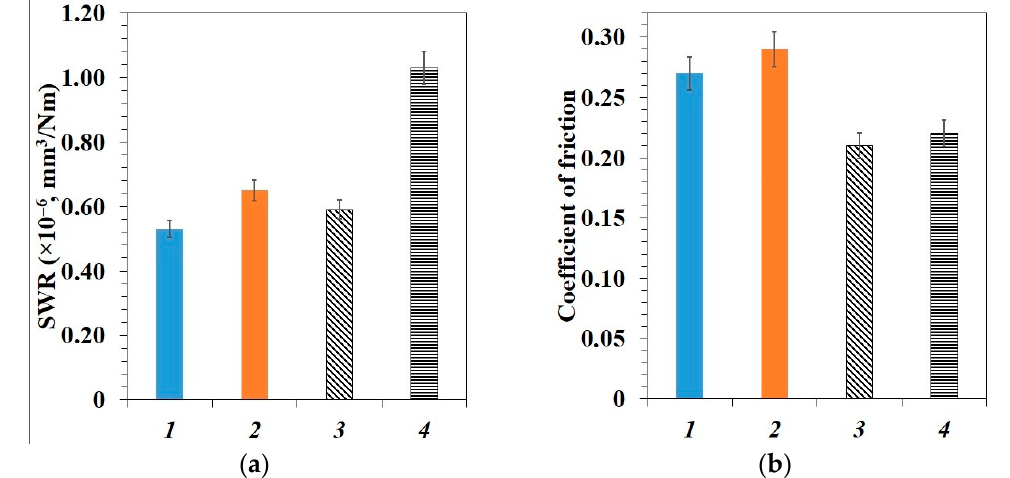
Figure 10. Comparison of PCM specific wear rate ( a ) and coefficient of friction ( b ) developed in this work with previously obtained data: 1 –PTFE/CF/ZrO 2 ; 2 –PTFE/CF/SiO 2 /BN; 3 –PTFE/CF/Zt; 4 –